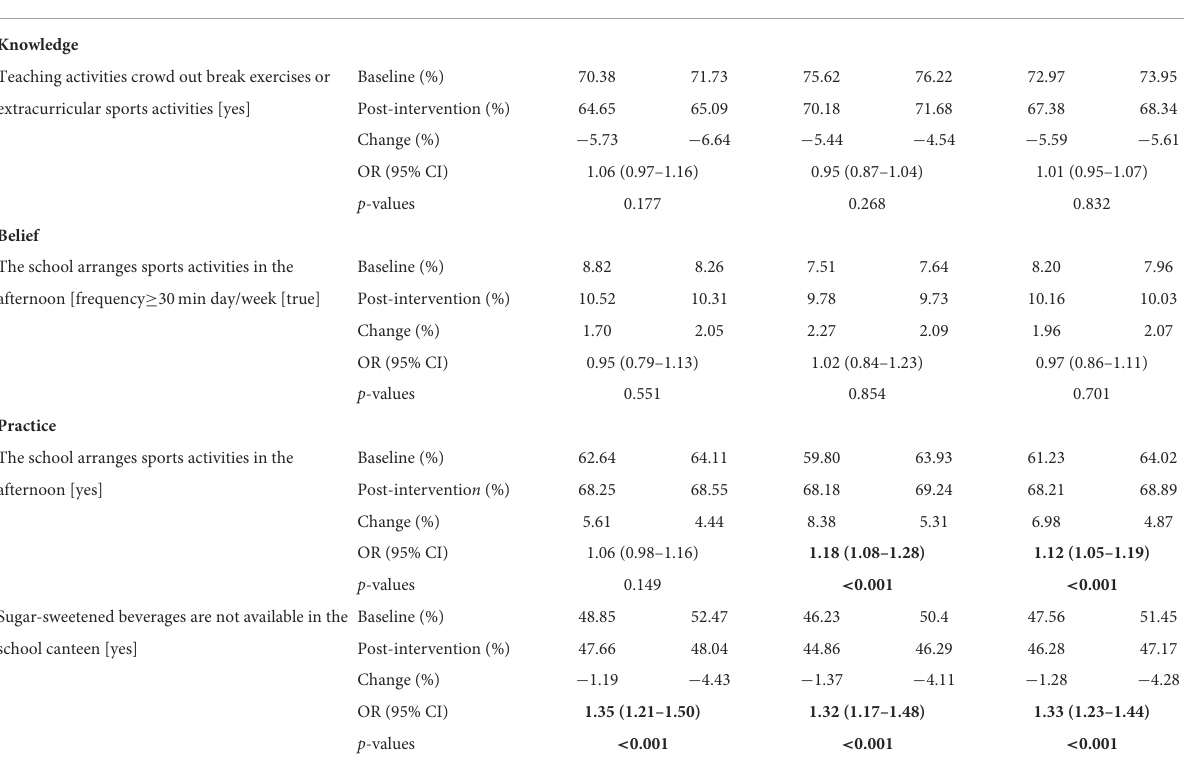
TABLE 6 Effectiveness on the school’s knowledge, belief, and